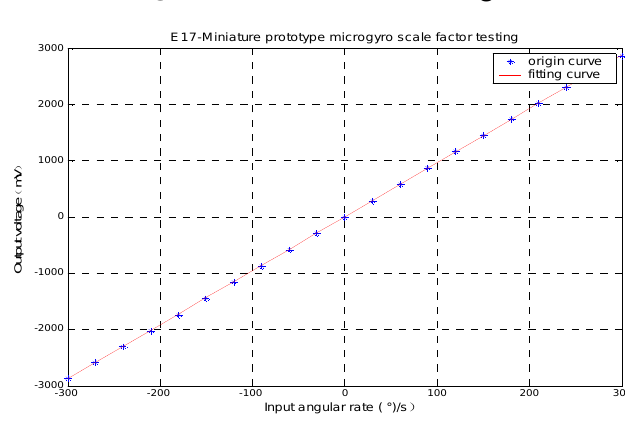
Figure 12. Scale factor testing.